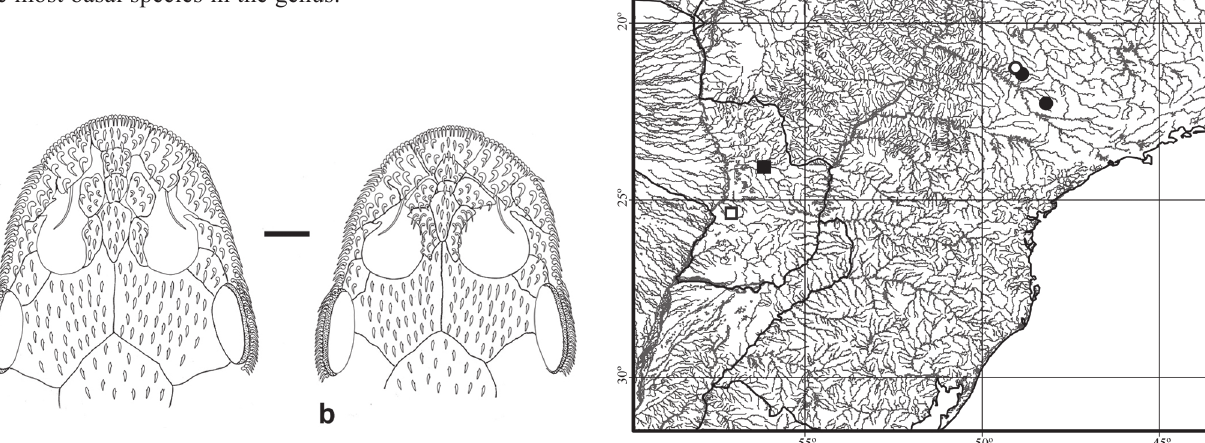
Fig. 7. Geographic distribution of Otothyropsis marapoama (dots) and O . piribebuy (squares). Open symbols for type